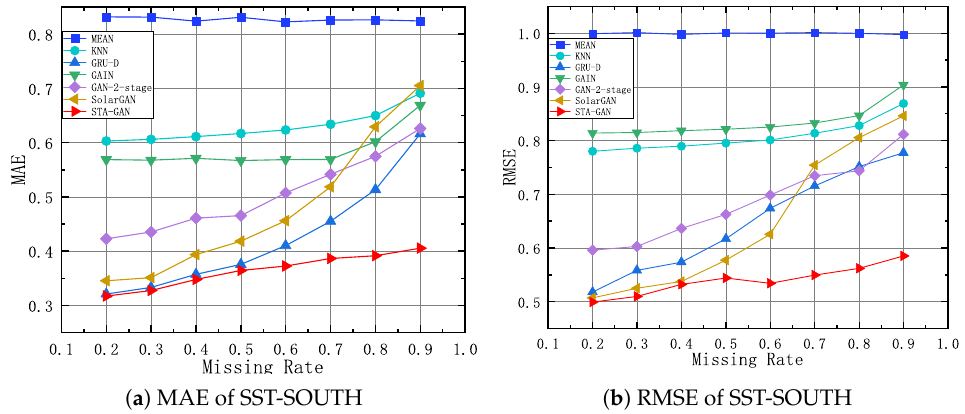
Figure 13. MAE and RMSE of SST-SOUTH dataset with different missing rates.